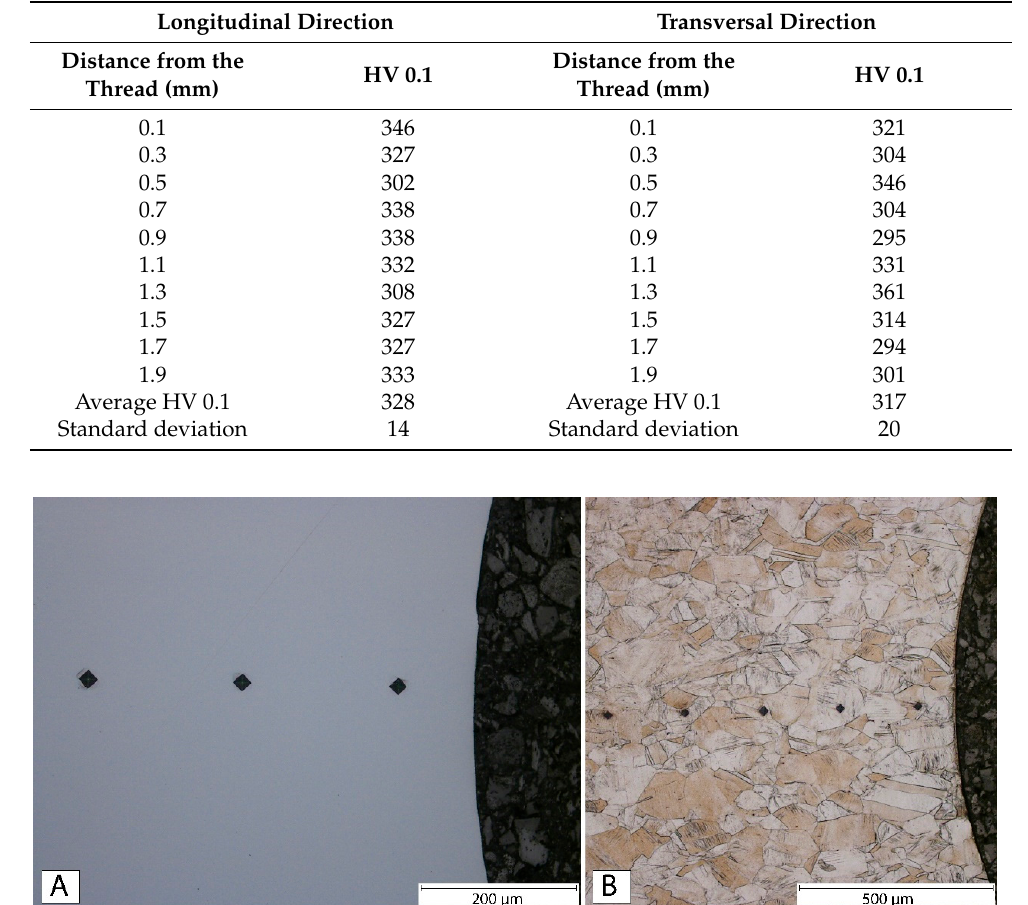
Table 2. Values of microhardness HV 0.1 for transversal and longitudinal cut direction.